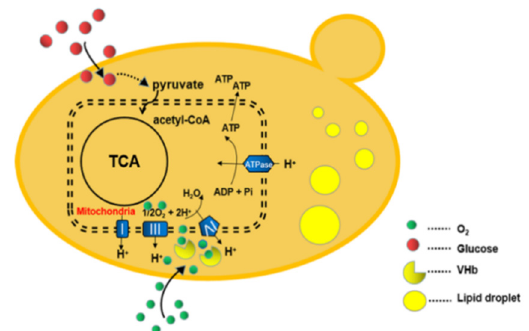
Figure 1. Schematic VHb-expression model regulating lipid production in R. toruloides . Oxygen gets into the cell and binds to VHb in the cytoplasm; the oxygen that bound to VHb is released in mitochondria, participates in the electron transport chain and produces more ATP for cell growth and lipid biosynthesis.